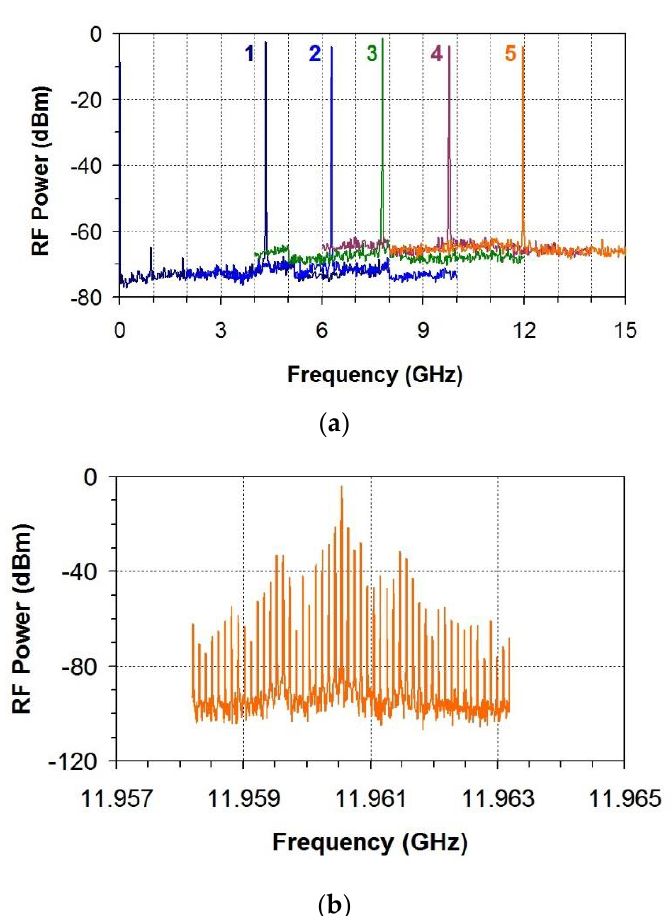
Figure 6. ( a ) Superimposed generation spectra obtained for the narrowband demodulation mode with different detuning of the carrier wavelength from the acetylene absorption line and ( b ) the generation spectrum, obtained with 12 GHz detuning and shown with higher resolution.